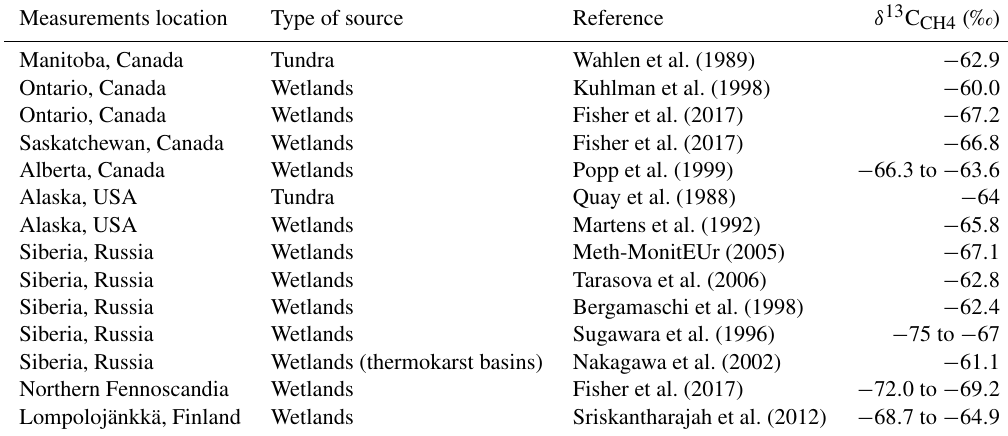
Table 3. δ 13 C CH4 source signatures reported for wetlands at high northern